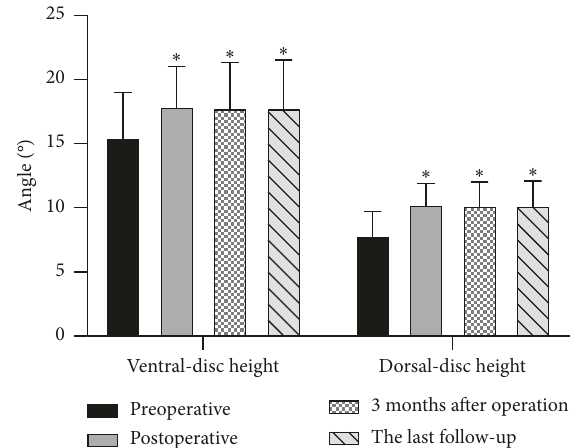
Figure 3: The comparisons of intervertebral disc height. Compared with preoperative, the height of ventral and dorsal intervertebral discs increased significantly with no loss of height at the last follow- up. ∗ P > 0 . 05 vs. preoperative.